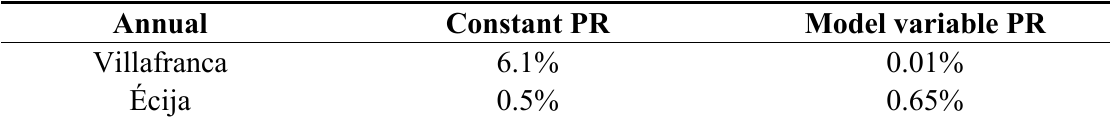
Table 9. Percentage differences between real and predicted annual EP with the two prediction